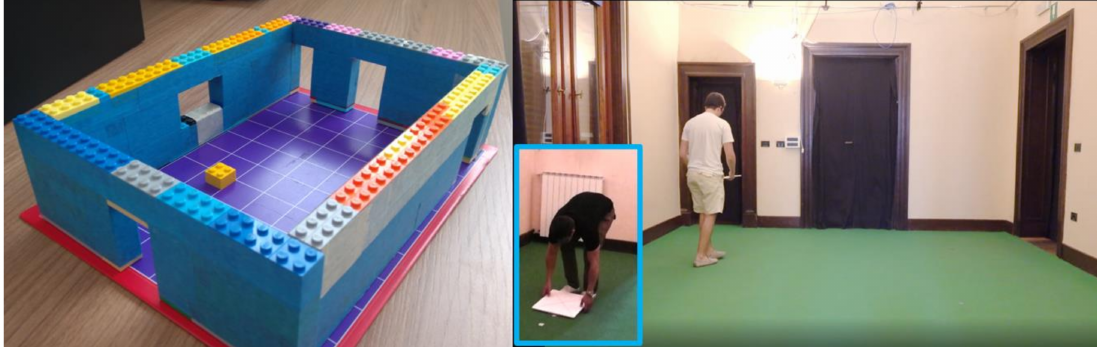
Figure A1. Left : Example of a map reconstructed with LEGO bricks. The four walls were presented detached from the magnetic floor. Right : Participant performing the navigation